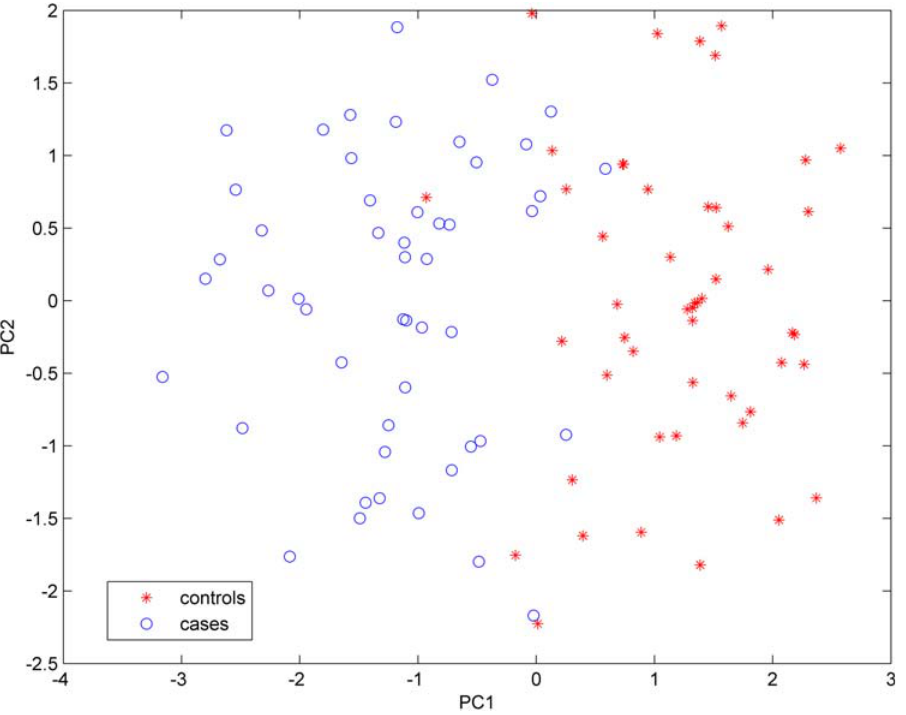
Figure 1. First two principal components extracted from SNPs that were selected by the method GLM1. The first principal component provides a nearly perfect separation of cases from controls.